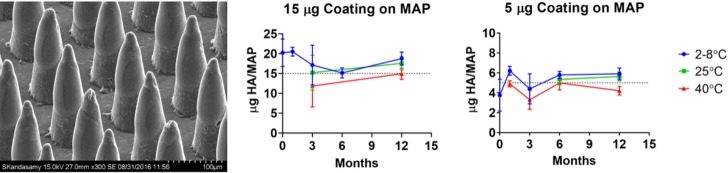
Coating and stability of A/Sing HA on HD-MAPs.The left-hand panel shows a scanning electron micrograph of HD-MAPs coated with A/Sing MPH. The coated vaccine is visible on the tips and top half of the projections. The graphs show stability of A/Sing HA on HD-MAPs coated with either 5 μg or 15 μg HA (in A/Sing MPH) indicated by the dotted line. Antigen-coated HD-MAPs were stored at 2 to 8°C, 25°C or 40°C at 60% ± 5% RH for 1, 3, 6, or 12 months. At each time point, antigen was eluted from the HD-MAP and the HA content determined by enzyme immunoassay. A/Sing, A/Singapore/GP1908/2015 H1N1; HA, haemagglutinin; HD-MAP, high-density microarray patch; RH, relative humidity.